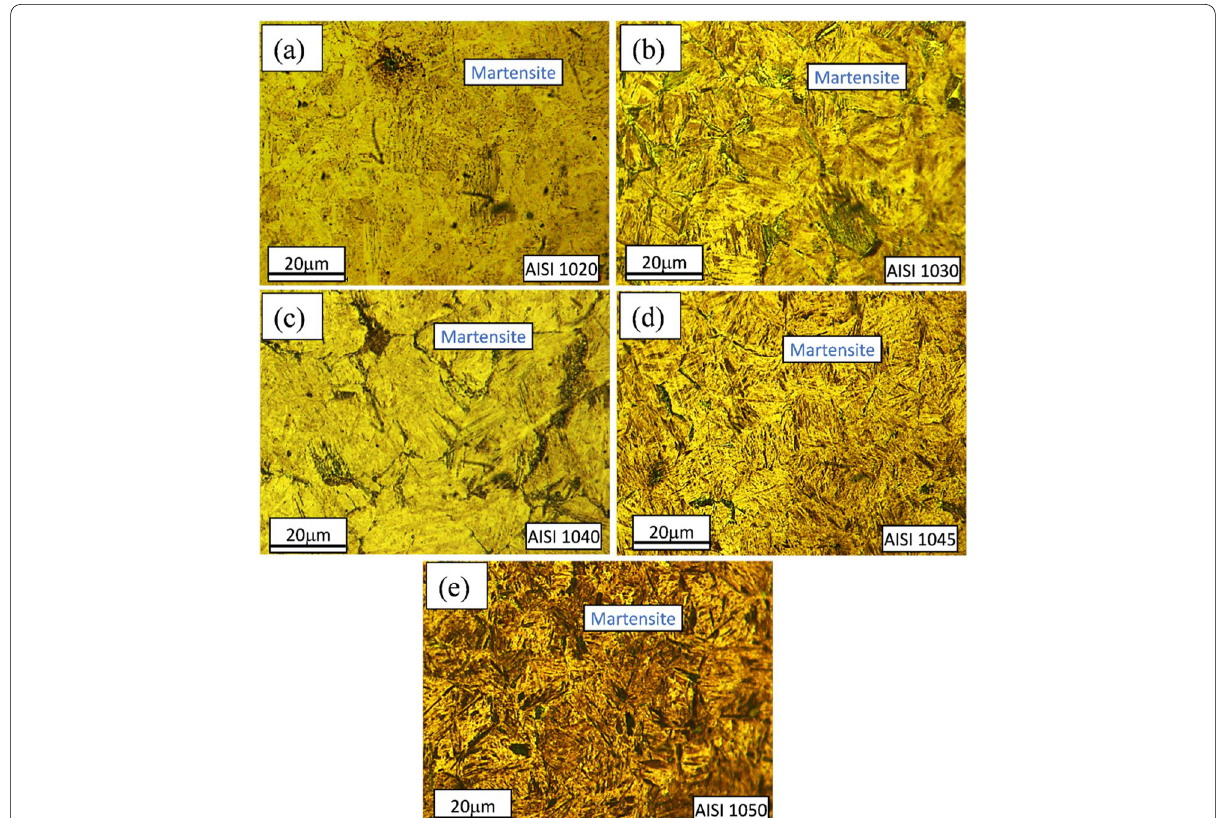
Fig. 4 Light Optical micrographs of AISI a 1020, b 1030, c 1040, d 1045 and e 1050 plain carbon steels obtained after quenching showing martensitic